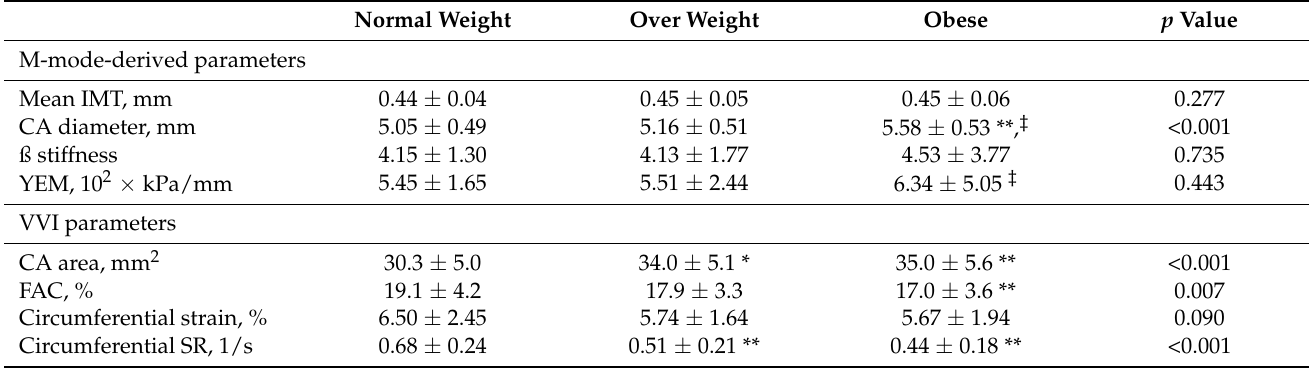
Table 2. Structural and functional characteristics of the carotid artery. Normal Weight Over Weight p